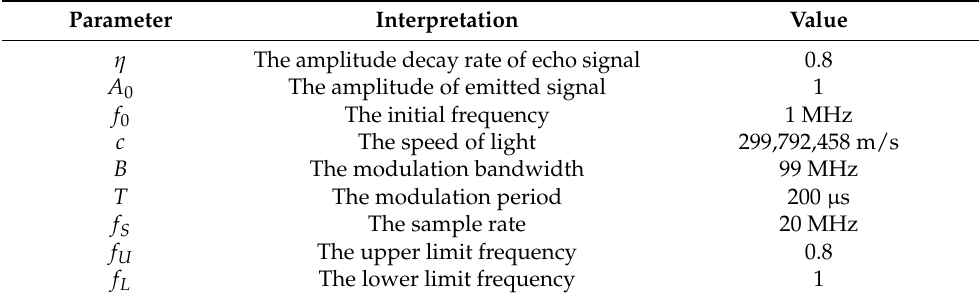
Table 1. The parameters used in the simulation and experiment. Parameter Interpretation Value η The amplitude decay rate of echo signal 0.8 A 0 The amplitude of emitted signal 1 f 0 The initial frequency 1 MHz c The speed of light 299,792,458 m/s B The modulation bandwidth 99 MHz T The modulation period 200 µ s f S The sample rate 20 MHz f U The upper limit frequency 0.8 f L The lower limit frequency 1